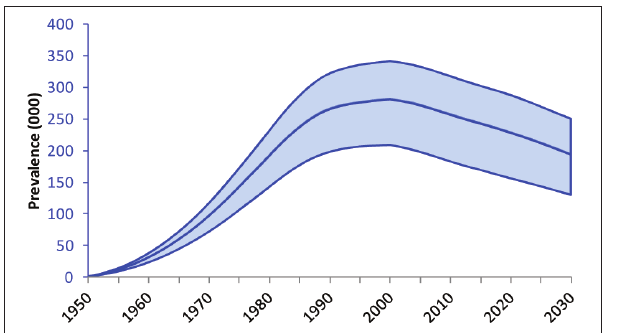
Figure 3) Total number of viremic hepatitis C cases (with uncertainty intervals) according to year, 1950 to 2035